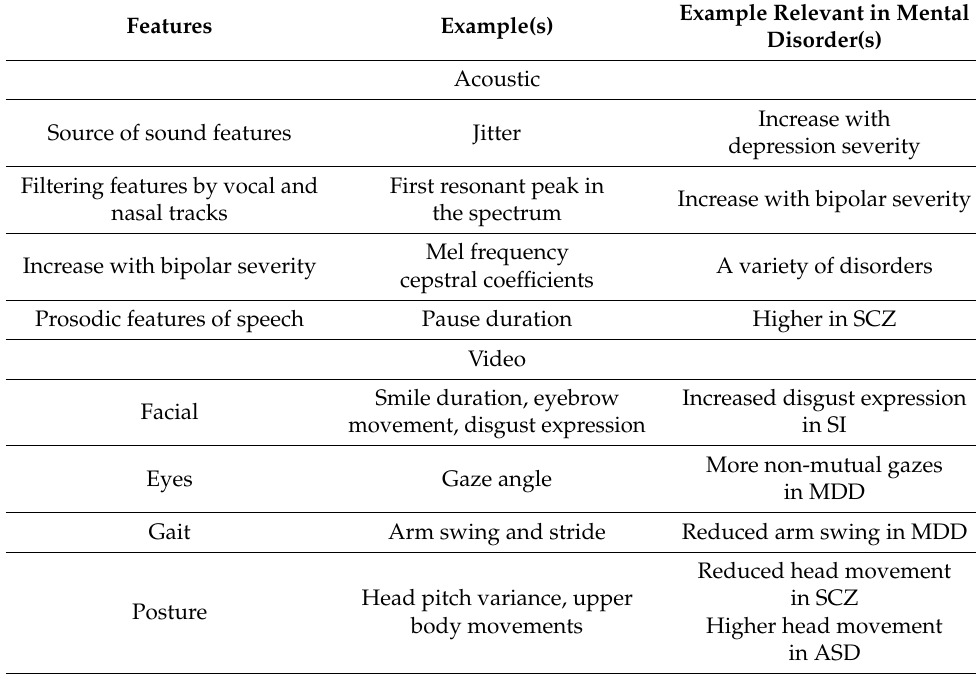
Table 1. Multimodal data features and their uses in mental health